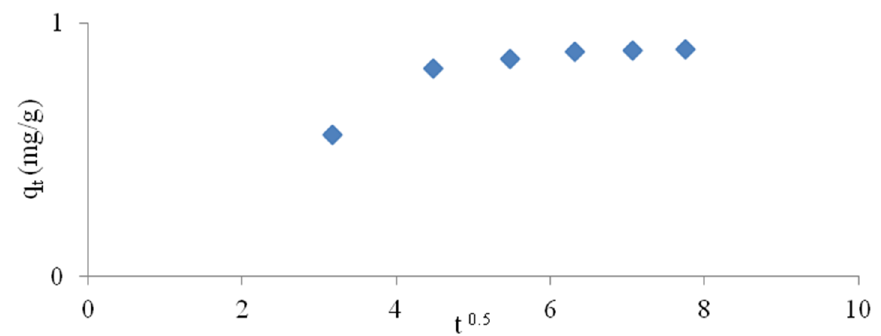
Figure 8. Intraparticle diffusion kinetic plot.